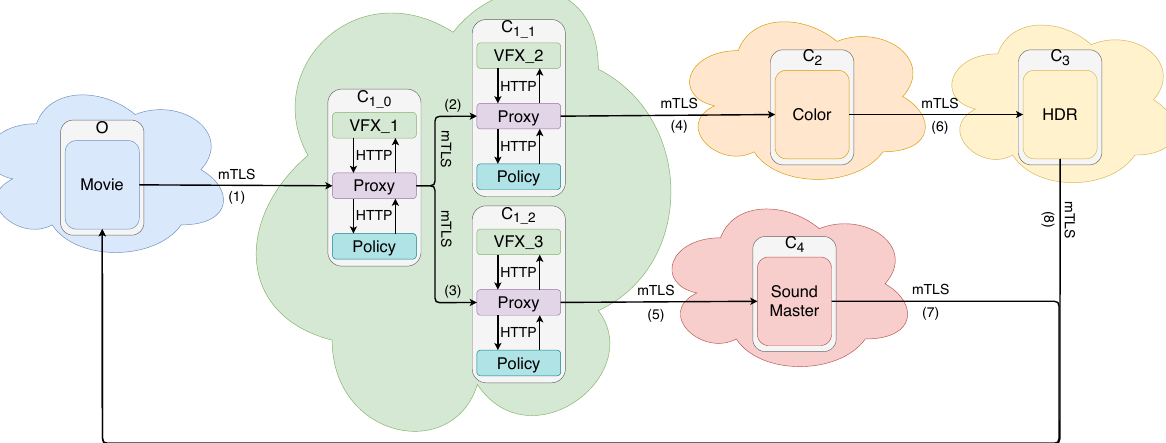
Figure 2. Secure infrastructure. Each box represents an agent. It is a pod with the appropriate containers. The container of the color of the actor represents the service. Purple containers represent the proxies of the service mesh, and blue containers represent the policy sidecars. The arrows stipulate whether the communications are secure ( mTLS ) or not